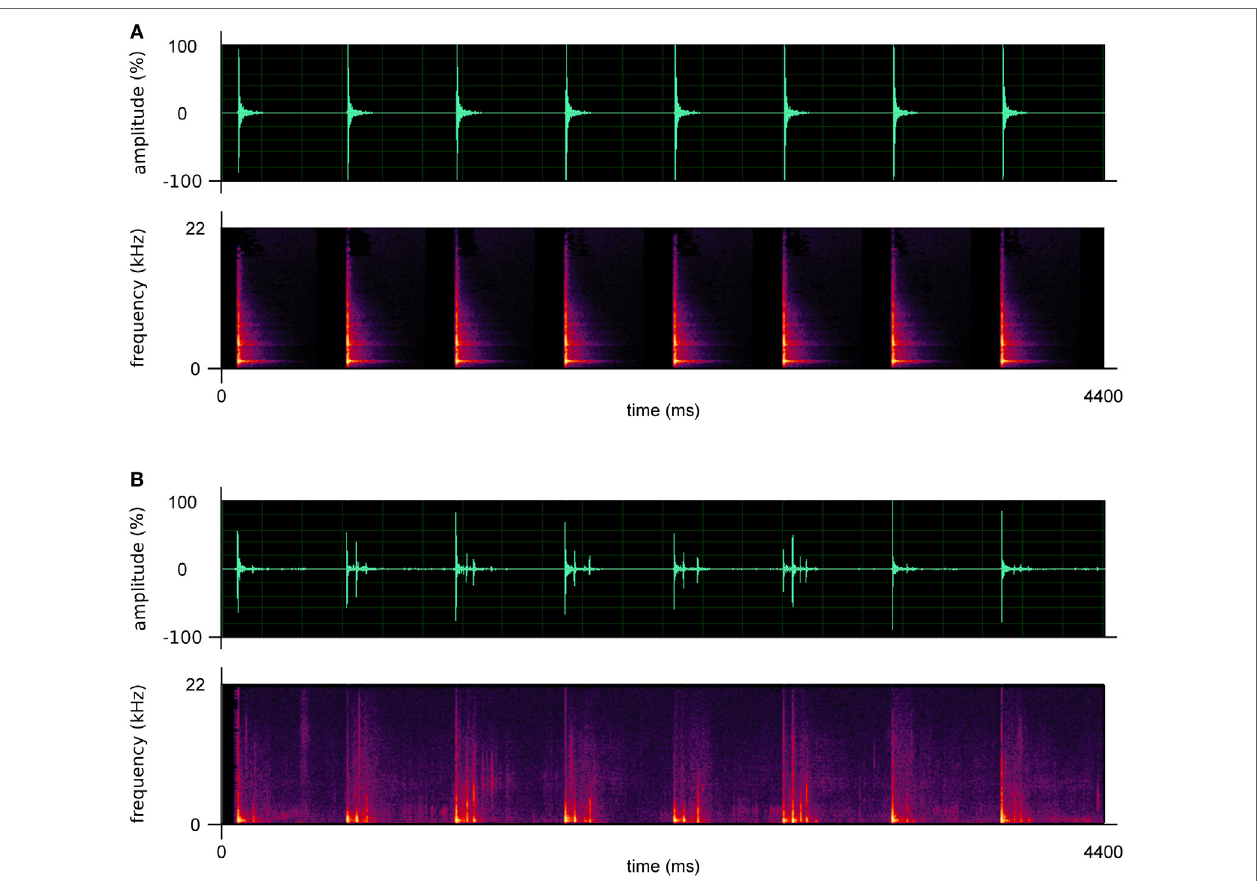
FiGUrE 2 | Prototypical examples of the artificial (a) and ecological sounds (B) used in this study. The upper graphs describe the amplitude of the sounds; the lower graphs describe their